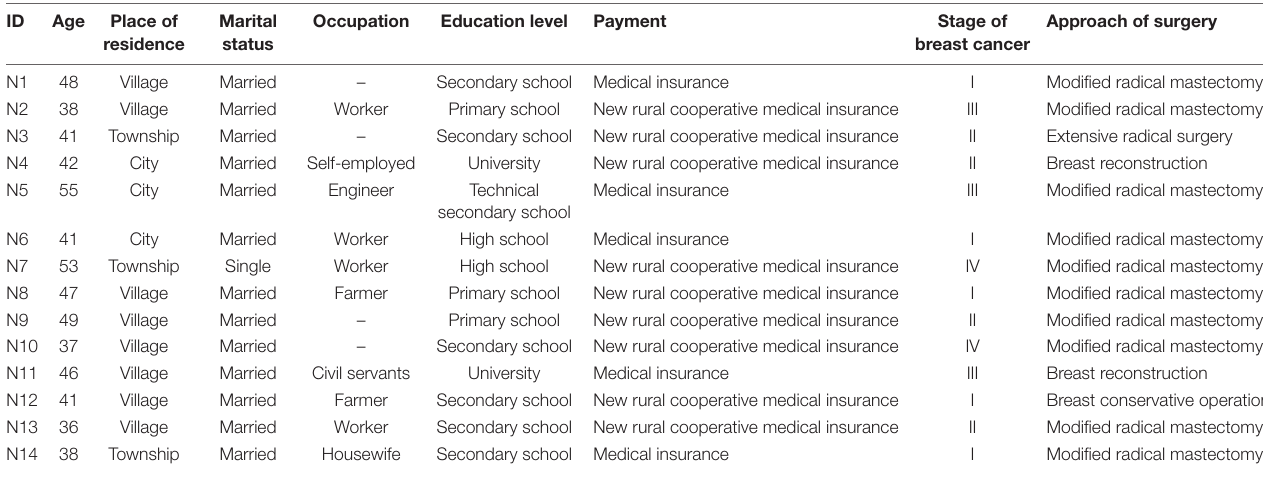
TABLE 1 | Participant